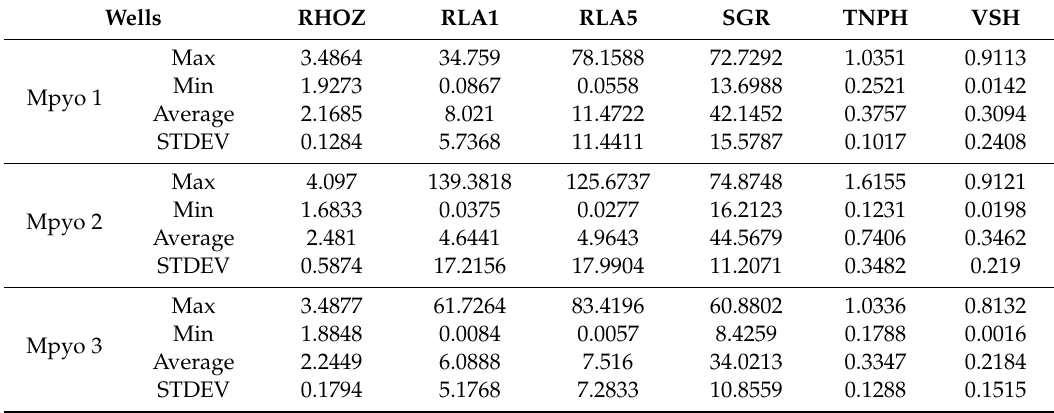
Figure 1. Location of Mpyo oil field found in the East African Rift Valley. Table 1. Statistical analysis of the data used.